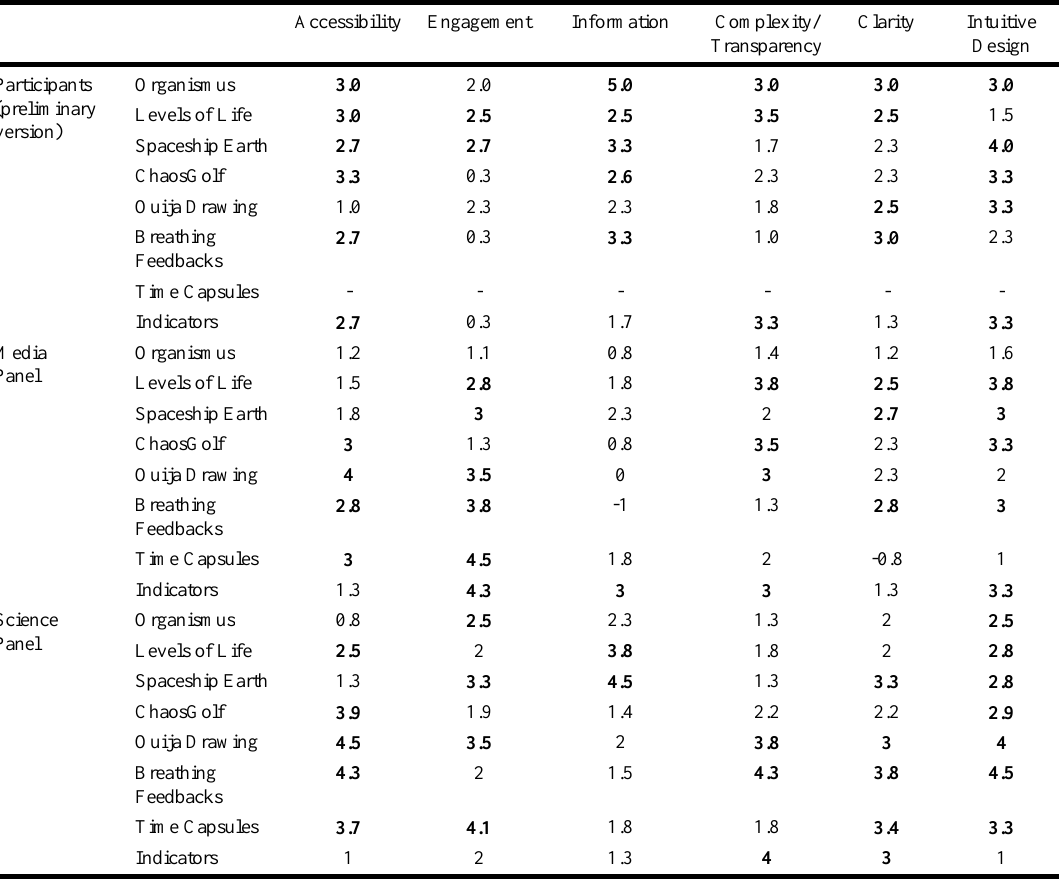
Table 1. Evaluation of concepts using design criteria by the participants, the design panel, and the science panel. Each number represents a rating between -5 and +5, with -5 standing for “extremely bad” and +5 for “extremely good.” Those in bold highlight values that are in the highest quadrant (+2.5 or higher). No values are in the lowest quadrant (-2.5 or lower). The participants evaluated preliminary versions of each concept. Time Capsules did not exist at the time of the preliminary versions of the other concepts.